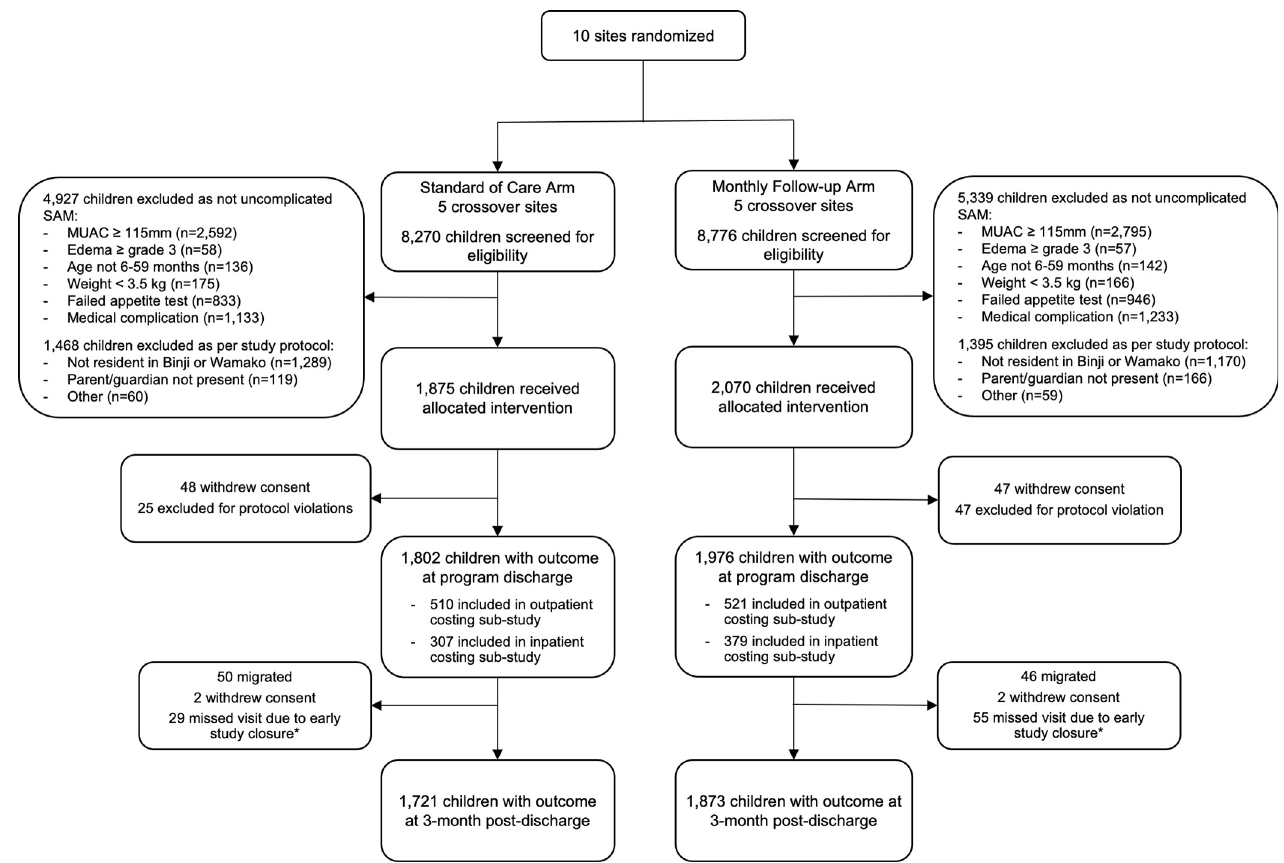
Fig 1. Flowchart of trial enrollment, randomization and follow